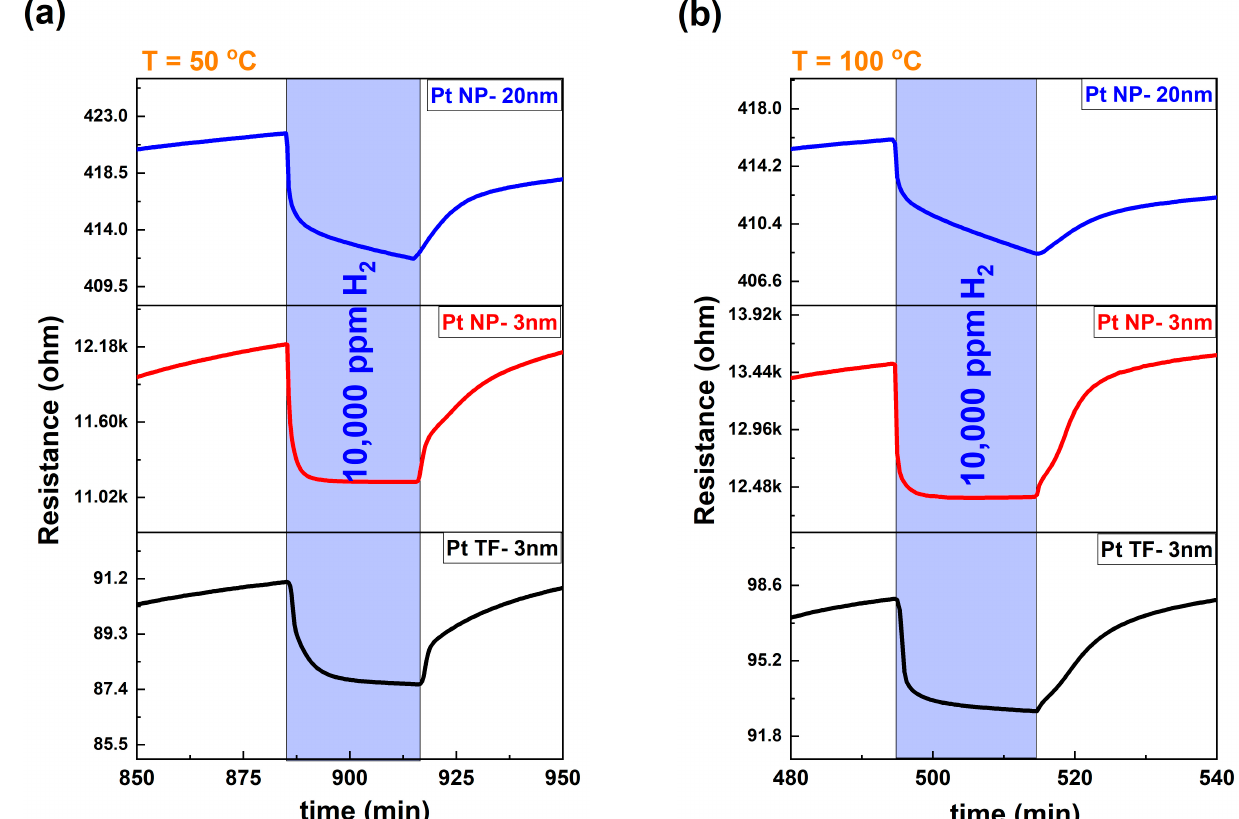
Figure 4. Comparison of isothermal dynamic resistance profiles of Pt sensors toward 10,000 ppm hydrogen at ( a ) 50 °C and ( b ) 100 °C.